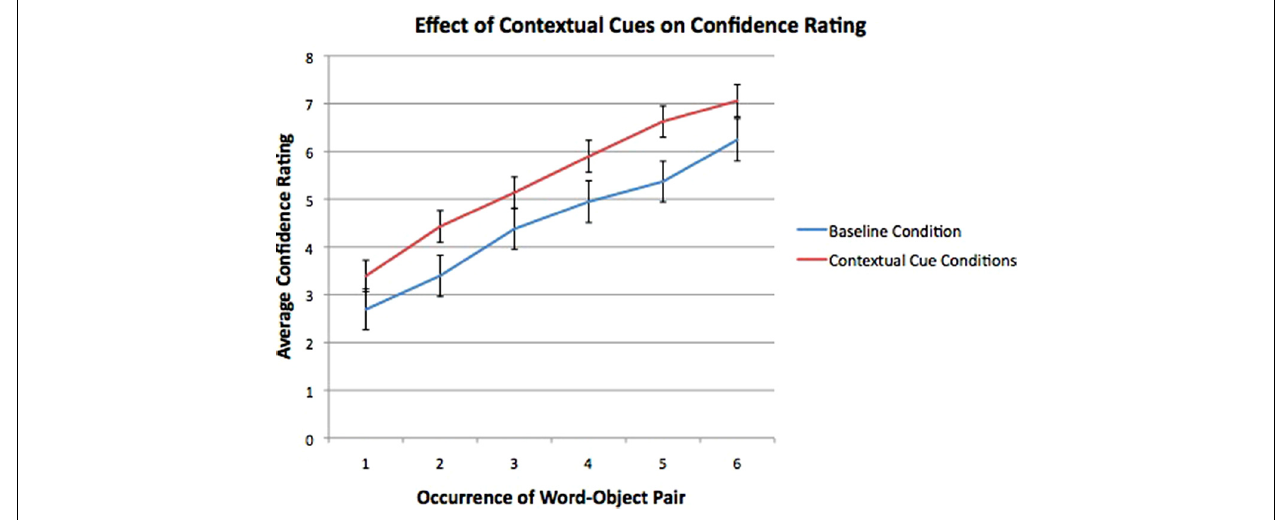
FIGURE 4 | Confidence ratings for 2:1 mappings in the second familiarization, with error bars representing one SEM. Confidence ratings for 2:1 mappings in the two contextual cue conditions (combined here and shown in red) were significantly higher than those in the baseline condition (shown in blue).